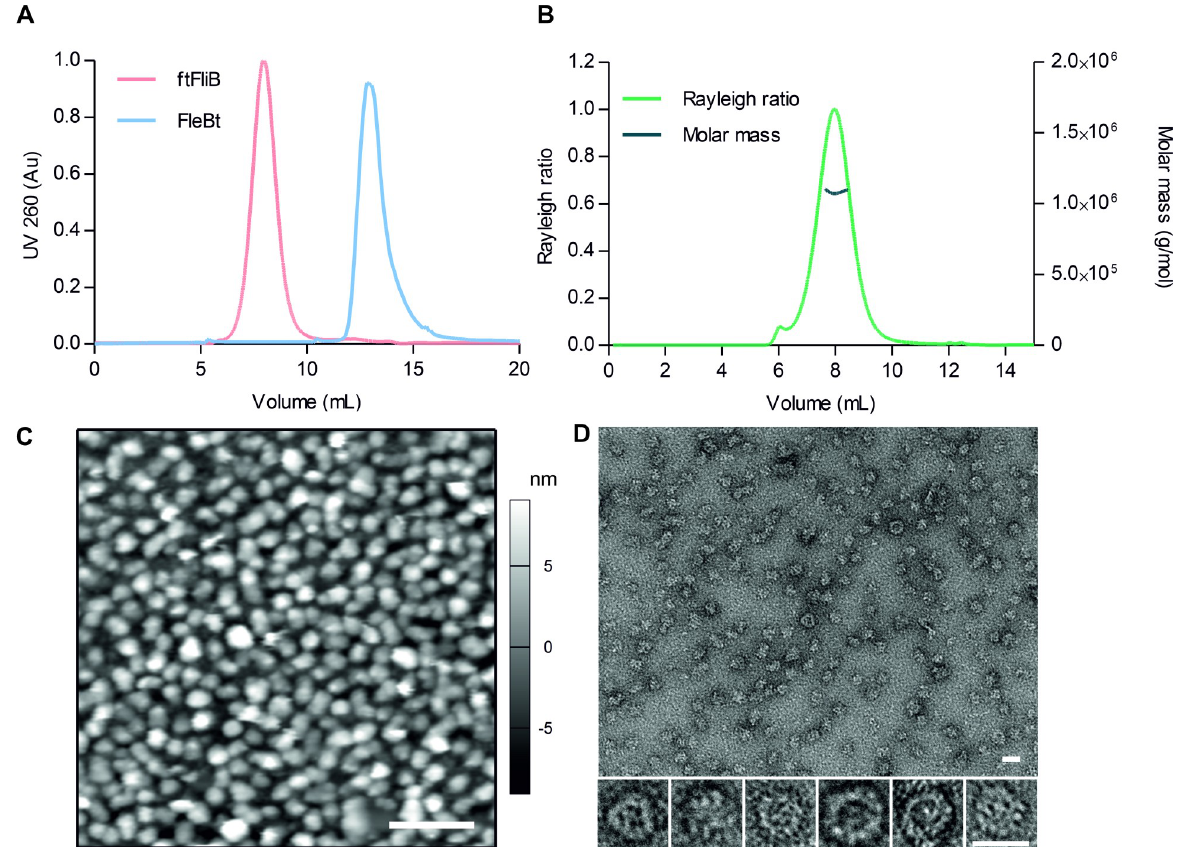
Fig 4. FliB forms a homo-oligomer. ( A ) Comparison of molecular size-exclusion chromatography of ftFliB and FleBt tag carried out on a TSK-GEL BioAssist G4SW XL column. ( B ) SEC-MALS analysis of ftFliB. The Rayleigh ratio (light scattering, LS) profile (light green, left axis) shows one major peak. The molar mass trace (dark green, right axis) across the elution peak derived from RI/LS measurements corresponds to homogeneous oligomeric states of ftFliB. ( C ) 2D-AFM height profile picture of purified ftFliB oligomers in buffer that have settled on a flat MICA surface. The grayscale color profile ranges from -9 nm (black) to 9 nm (white). Scale bar is 100 nm. ( D ) TEM of purified ftFliB oligomers with particles of distinct globular shape enlarged below. Scale bars correspond to 25